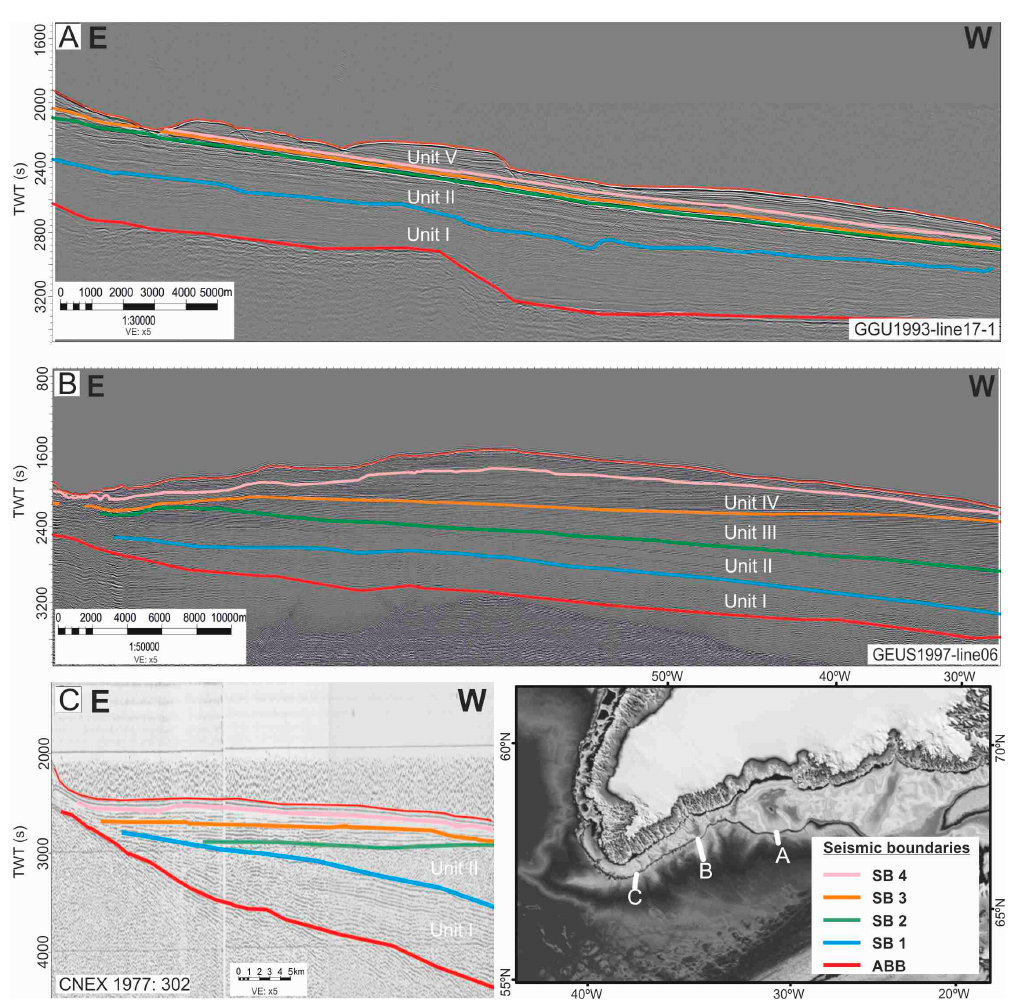
Figure 5. ( A – C ): Three across slope seismic profiles representing evolution of the drift deposits in the study area. The map shows the location of the seismic